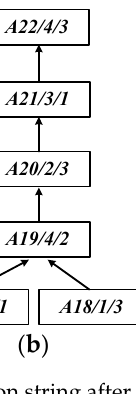
Figure 5. Each operation string after the second decomposition of operation string T A2 : ( a ) Opera ‐ tion string T A21 ; ( b ) Operation string T A22 . string T A21 ; ( b ) Operation string T A22